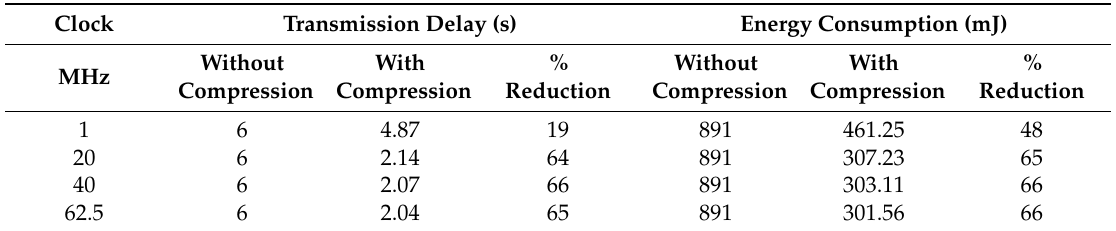
Table 8. Energy and delay reduction for ECG_EkgMove using shimmer BT nodes.